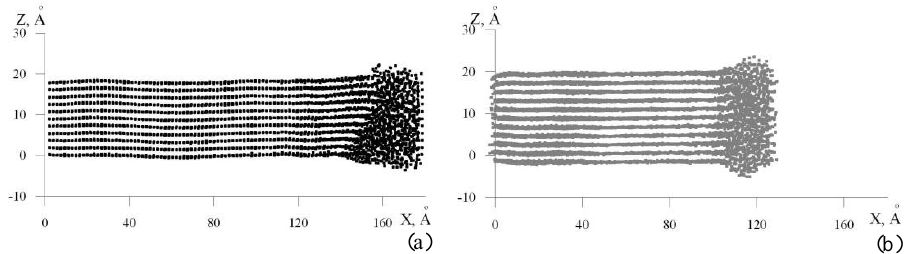
Fig. 11. View of the perfect (a) and amorphized (b) nanosized rod in XZ plane 10 ps after the beginning of external cyclic action.